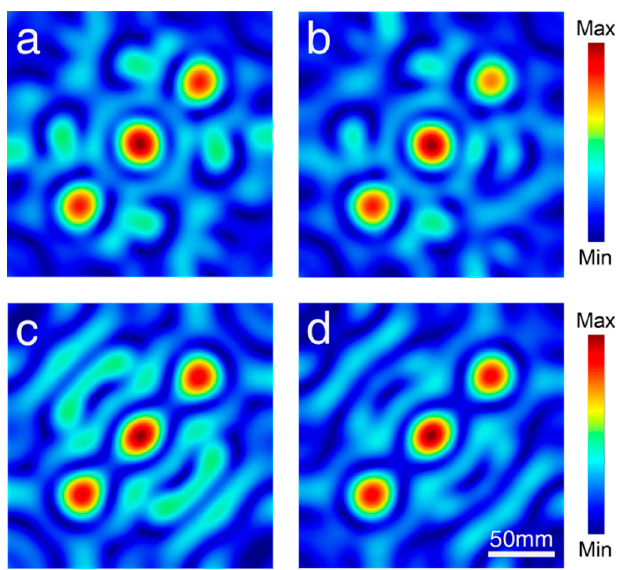
Figure 6. Simulated acoustic amplitude distributions under different working frequencies. ( a – d ) The imaging distance is 20 mm while the working frequency was 6.9 kHz, 6.95 kHz, 7.05 kHz, and 7.1 kHz, respectively.